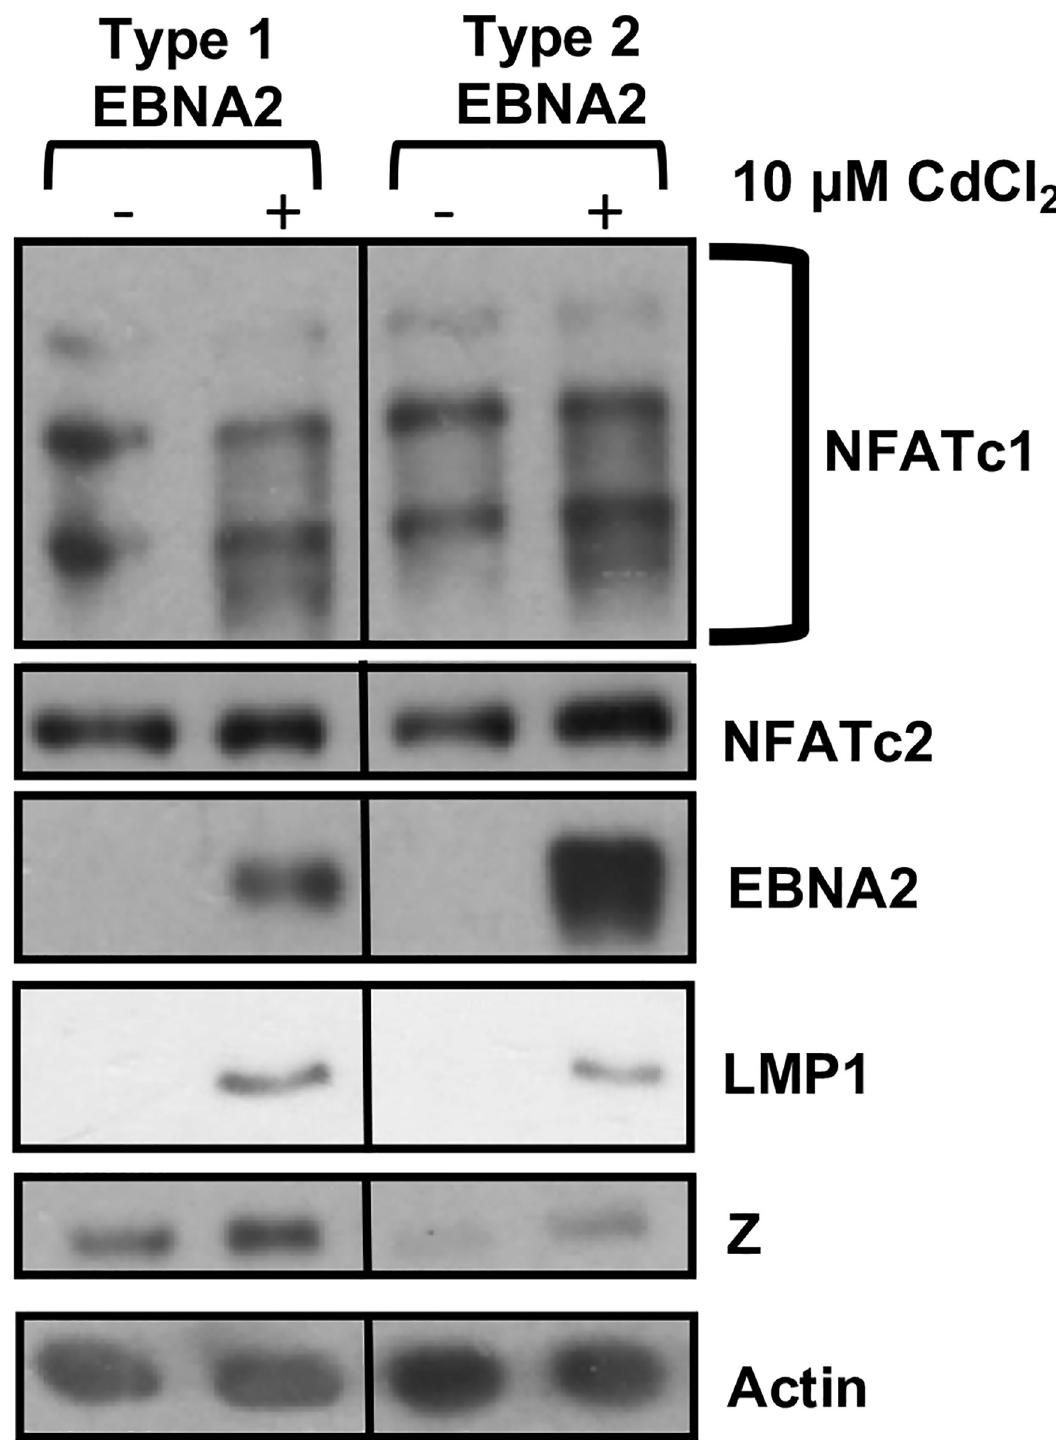
Fig 12. T1 and T2 EBNA2 expression have similar effects on NFATc1/NFATc2 expression in P3HR1 Burkitt lymphoma cells. P3HR1 cells containing either T1 or T2 pHEBo-MT-EBNA2 constructs were treated with or without 10 μ M CdCl 2 for 48 hours to induce EBNA2 expression. Immunoblot analysis was performed on whole cell extracts using antibodies against NFATc1, NFATc2, EBNA2, LMP1, Z, and actin.